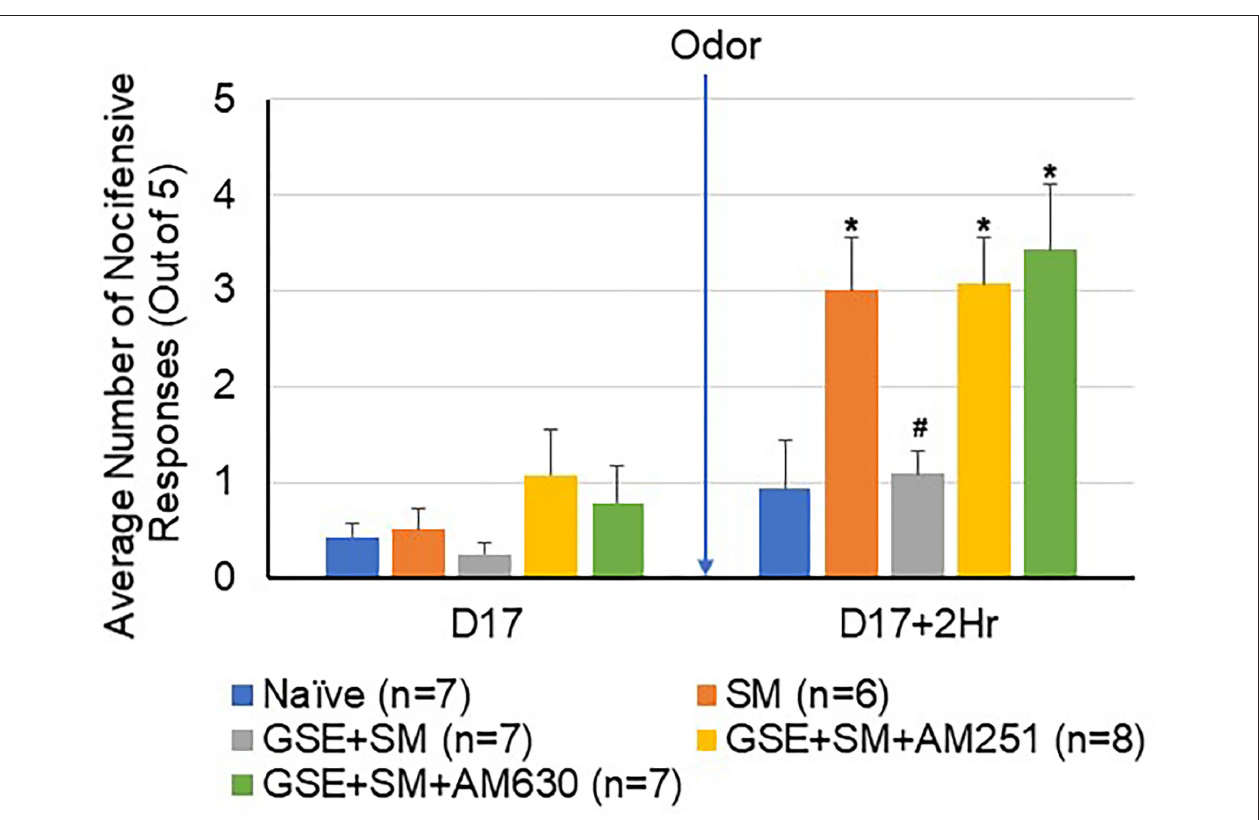
FIGURE 4 | The inhibitory effect of GSE on hindpaw nocifensive behavior involves CB1 and CB2 receptors. The average number of withdrawal responses to mechanical stimulation of the hindpaw is reported for male and female animals. Some animals were left untreated (Naïve) while other animals were subjected to restraint stress (SM). Some animals received daily GSE in lieu of water for 1 week prior to restraint stress and supplementation was continued for remainder of study (GSE + SM). The GSE + SM + AM251 animals received intracisternal injection of the CB1 antagonist AM251 while the GSE + SM + AM630 animals were injected with the CB2 antagonist immediately before exposure to the pungent odor. * P < 0.05 when compared to Naive levels for that condition, # P < 0.05 compared to SM